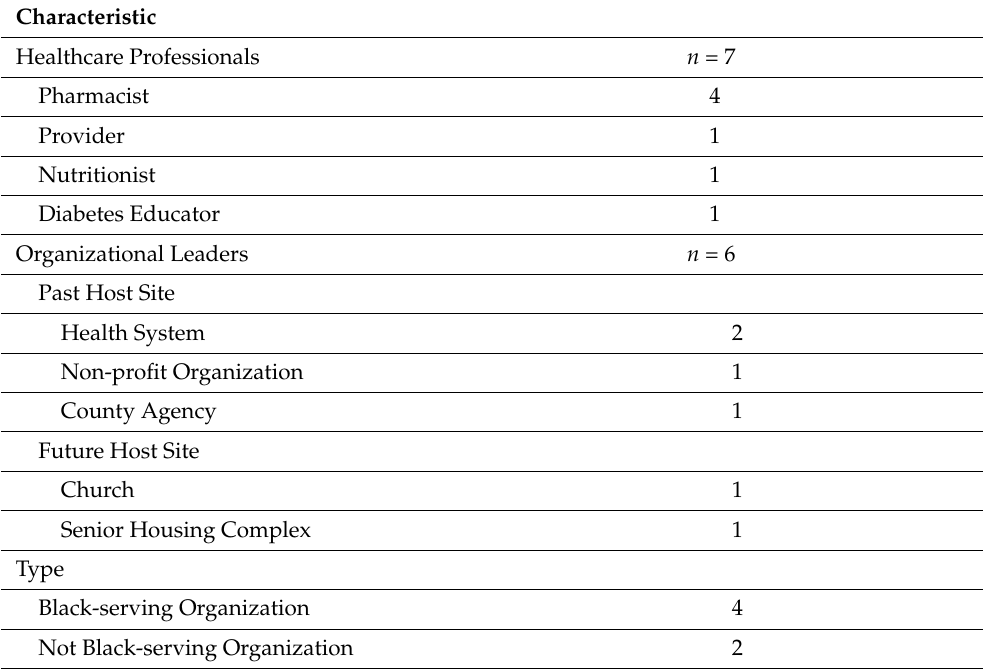
Table 2. Stakeholders’ Characteristics ( n =